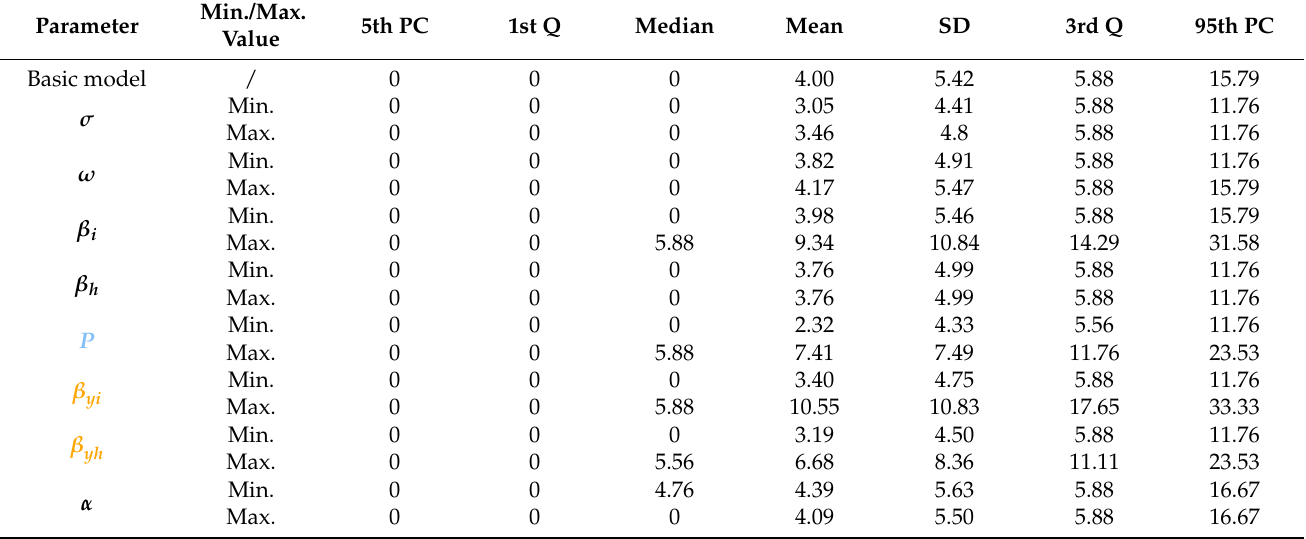
Table 5. Proportion of subclinically infected cows from the sensitivity analysis of the epidemio- logically most significant parameters. The parameters and their values in the basic model and the sensitivity analysis are defined in Table 3. Percentile, PC; quantile, Q; standard deviation, SD.